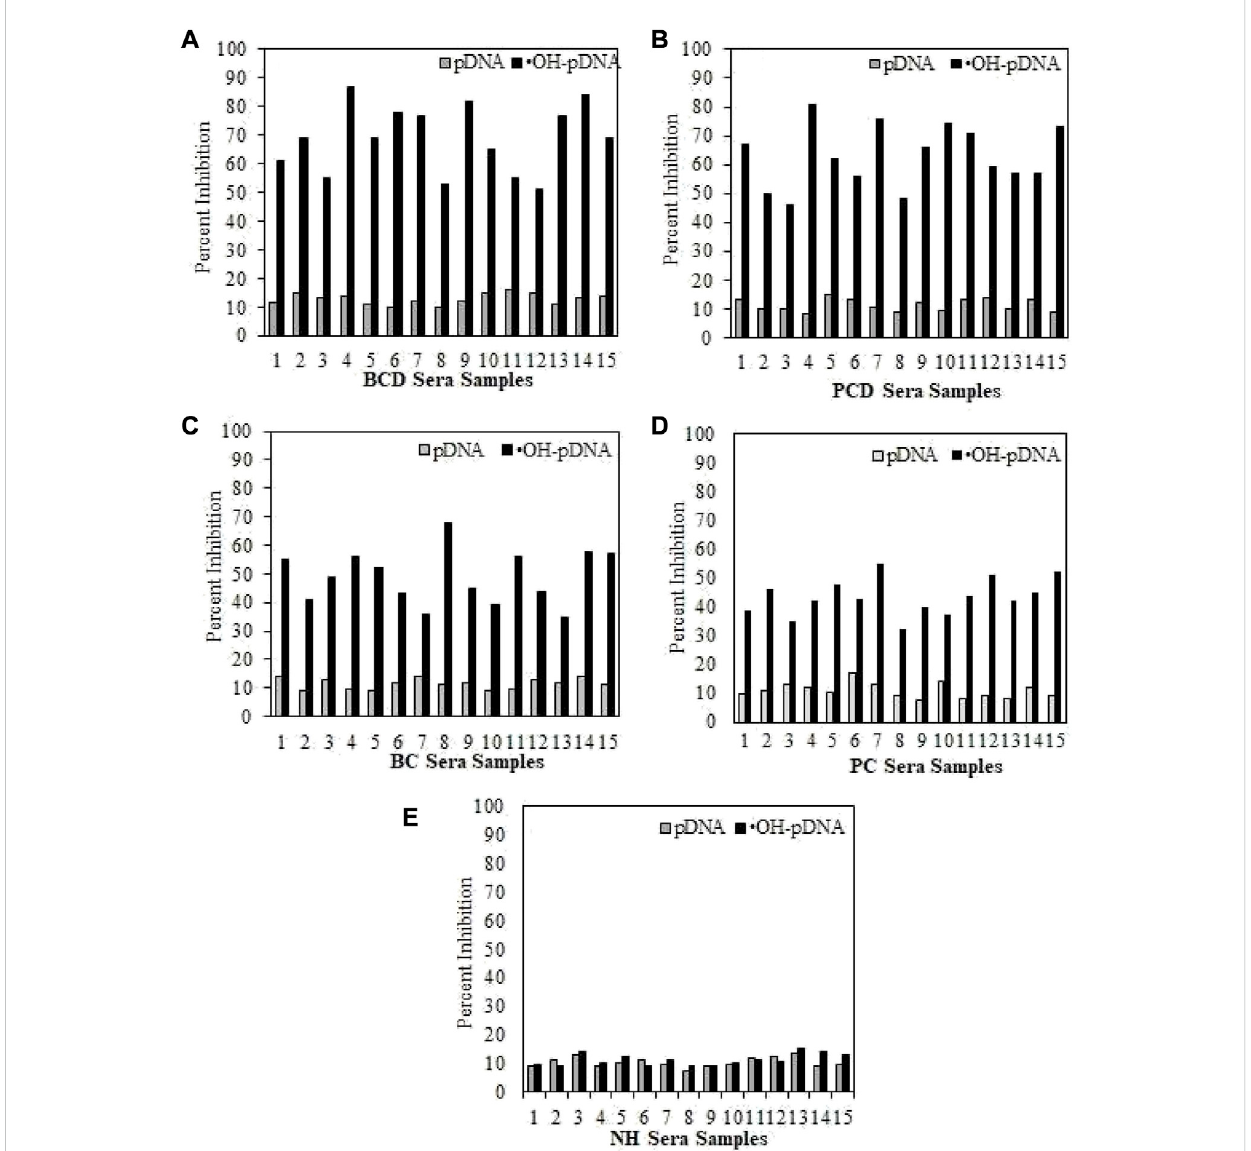
Inhibition ELISA for cancer and normal human subjects against native and modi fi ed antigens (10 μ g/mL). maximum percent inhibition at 10 μ g/mL were assessed for serum samples from BCD (A) , PCD (B) , BC (C) , PC (D) and NH serve as controls (E) . Each sample was tested in triplicates and the values given are in mean ±